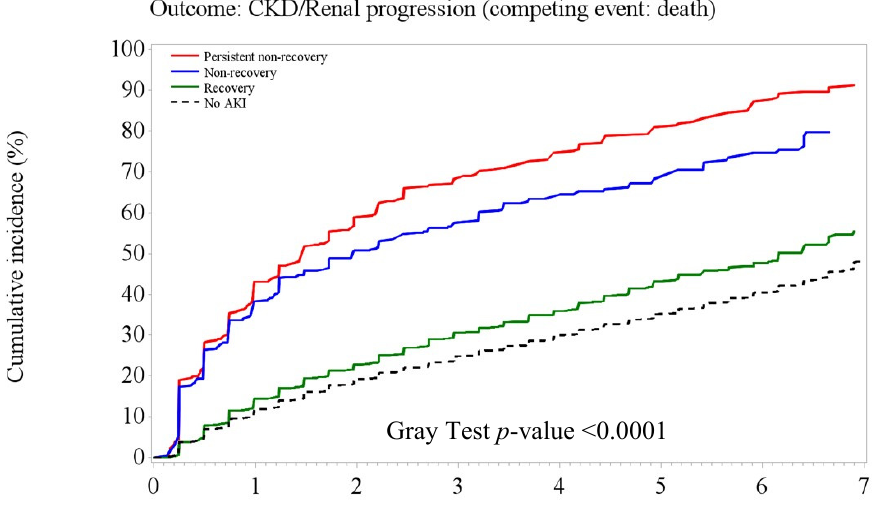
Figure 3. Cumulative risk of adverse kidney outcomes by acute kidney injury recovery patterns at 6 months after the index hospital discharge in the naïve 6-month survival cohort ( n = 48,357).